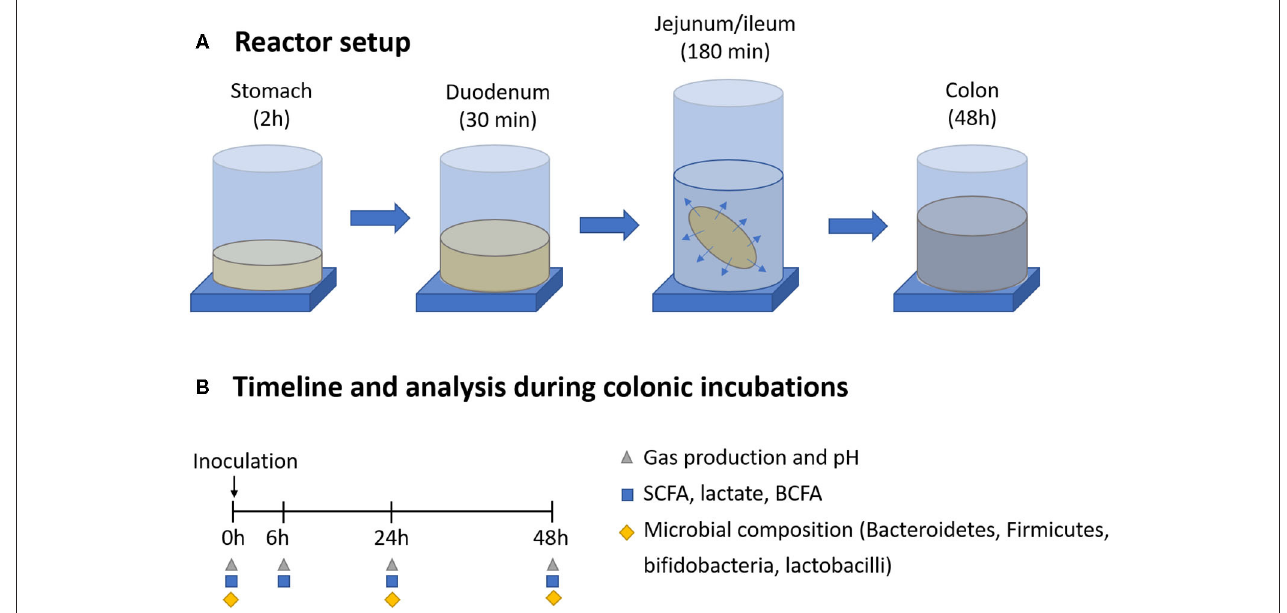
FIGURE 1 | Overview of the gastrointestinal digestion and colonic incubation (A) , including sampling points and downstream analysis (B) .